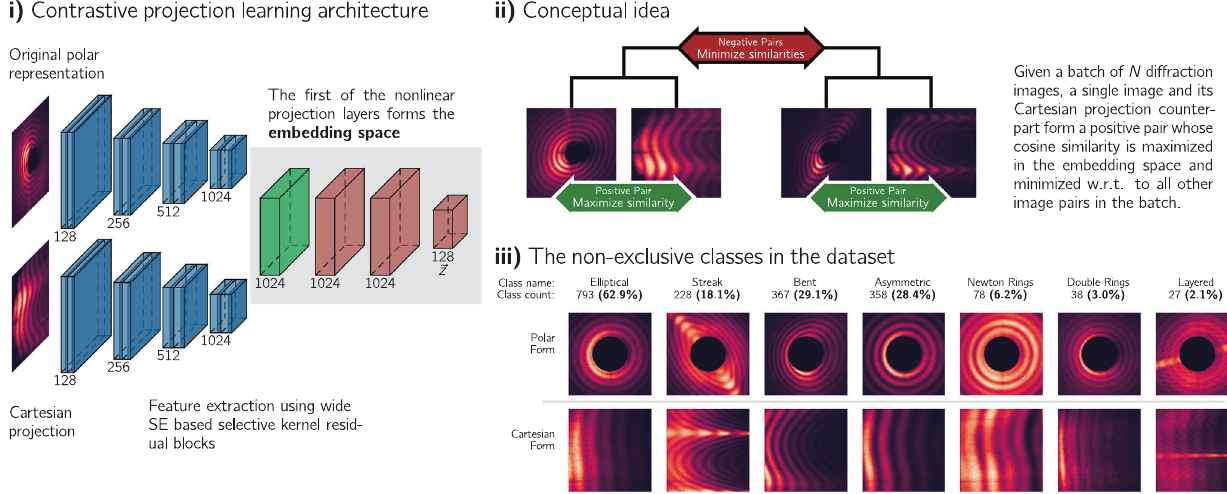
Fig. 2 The details on the CPLR architecture, the concept, and the classes within the dataset. i) Schematic of the used architecture. In this example, a positive pair, consisting of one diffraction image in its natural Polar and its Cartesian form, are passed on to the feature-extractor network, a modi fi ed ResNet50-D 61 . The adjacent grey box then shows the transformation network, a three layer MLP, where the fi rst layer — in green — forms the embedding space within the here used SimCLRv2 17 framework. ii) The conceptual idea in more detail. The goal during training is to maximize similarity (minimize distance in embedding space) for positive pairs and minimize similarity (maximize distance in embedding space) for negative pairs. iii) The seven possible, non-exclusive classes of the here used multiclass and multilabel dataset. The top row shows the diffraction image in Polar coordinates and the bottom row the Cartesian projection. In addition, the absolute and relative class counts are given alongside the class names. Several different features can appear in a single image which then belongs to several classes simultaneously. For example, a Streak feature is also present in the example for the Layered